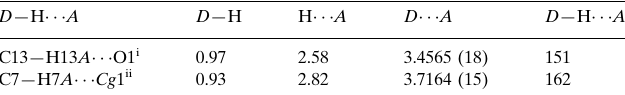
Hydrogen-bond geometry (A˚ , (cid:1)